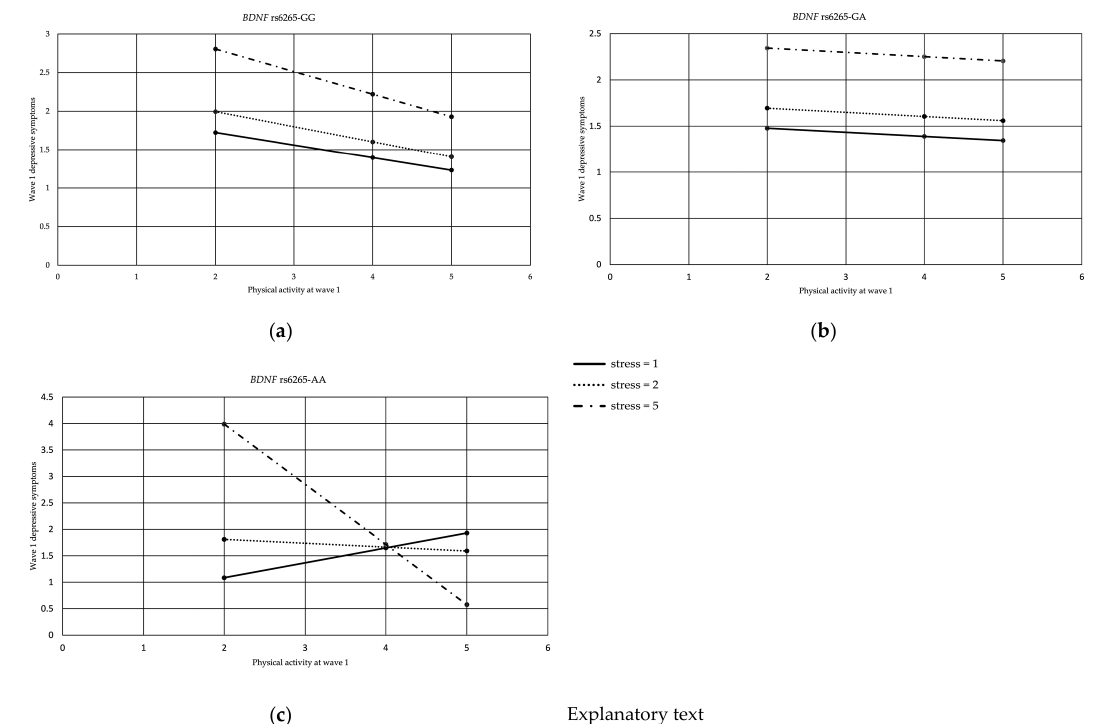
Figure 6. Interaction between BDNF rs6265, physical activity and childhood stress at different levels of stress in wave 1 in Model 3. ( a ) BDNF rs6265 GG, ( b ) BDNF rs6265 GA and ( c ) BDNF rs6265 AA. Figure 6 compares the interactions of the BDNF rs6265 GG, GA and AA genotypes with childhood stress and physical activity and their relationship with the number of de- pressive symptoms. The horizontal axis shows physical activity, the vertical axis shows the number of depressive symptoms, and three lines show the level of childhood stress (the continuous line for childhood stress = 1, the series of points line for childhood stress = 2 and the dashed line for childhood stress = 5). Figure 6c shows that for carriers of the AA genotype who had experienced a high level of childhood stress (5), increased physical activity reduced the number of depressive symptoms. This effect was reduced at a mod- erate stress level (2), and no interaction was observed at the low stress level (1). In Figure 6a, b for the BDNF rs6265 GG and GA genotypes, respectively, the reduction in depressive symptoms as an interaction effect of childhood stress and physical activity shows a similar trend for different levels of childhood stress.